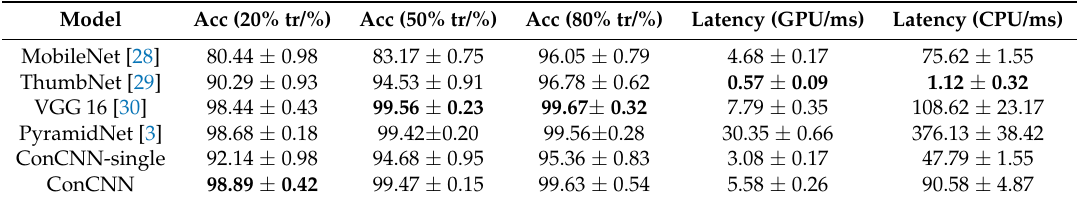
Table 2. Comparison results over various number images in training